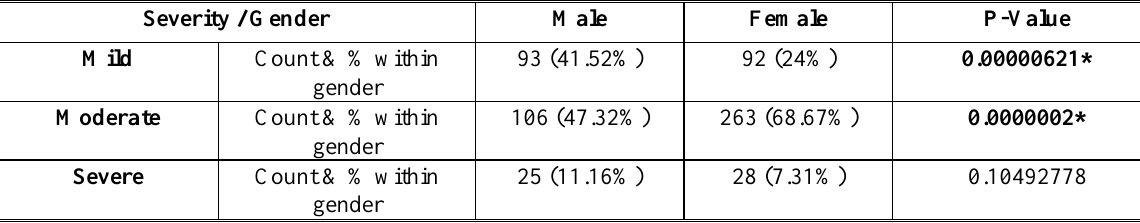
Table 7. Severity levels distribution among gender.”